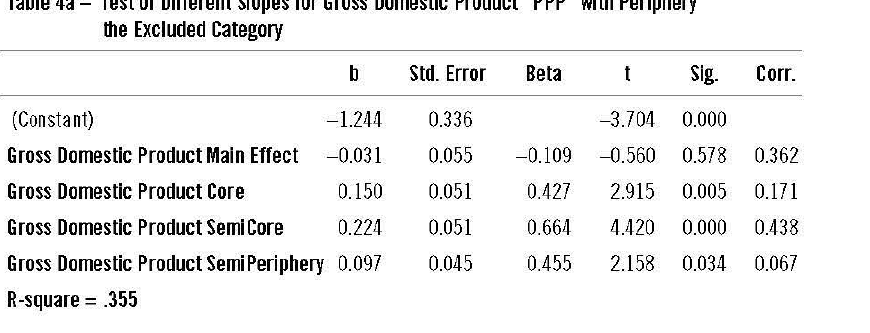
Table 4 - World-System Position by Gross Domestic Product "PPP" Interactions Table 4a - Test of Different Slopes for Gross Domestic Product "PPP" with Periphery the Excluded Category